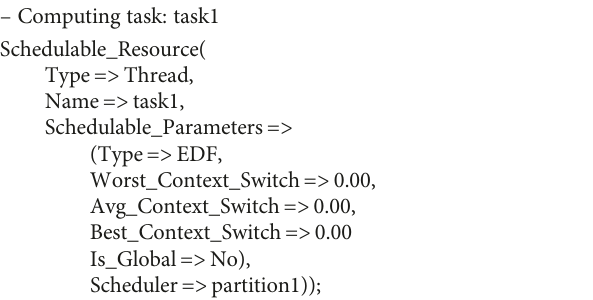
Table 9: Scheduling_Resource model element description.